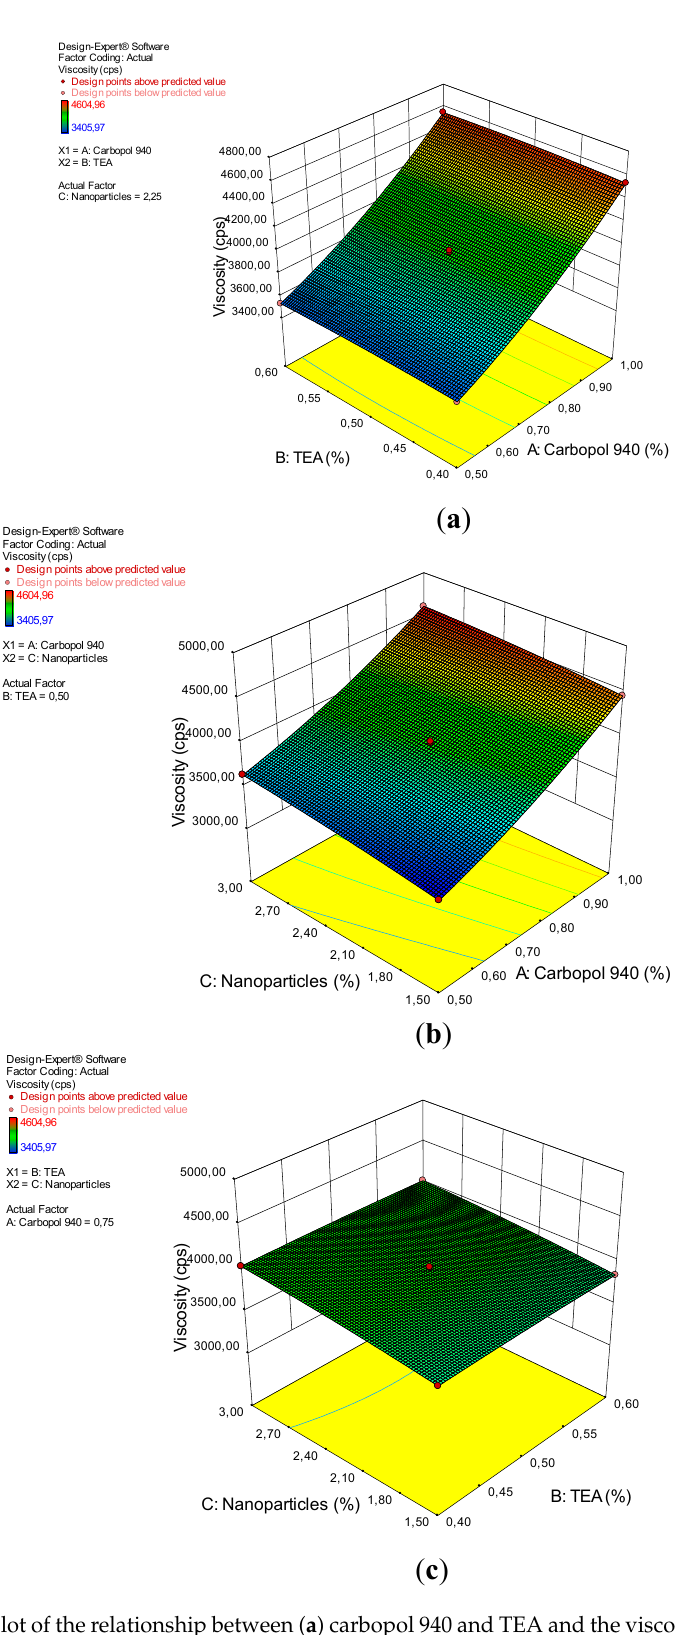
Figure 5. A 3D plot of the relationship between ( a ) carbopol 940 and TEA and the viscosity, ( b ) carbopol 940 and nanoparticles and the viscosity, and ( c ) TEA and nanoparticles and the viscosity.